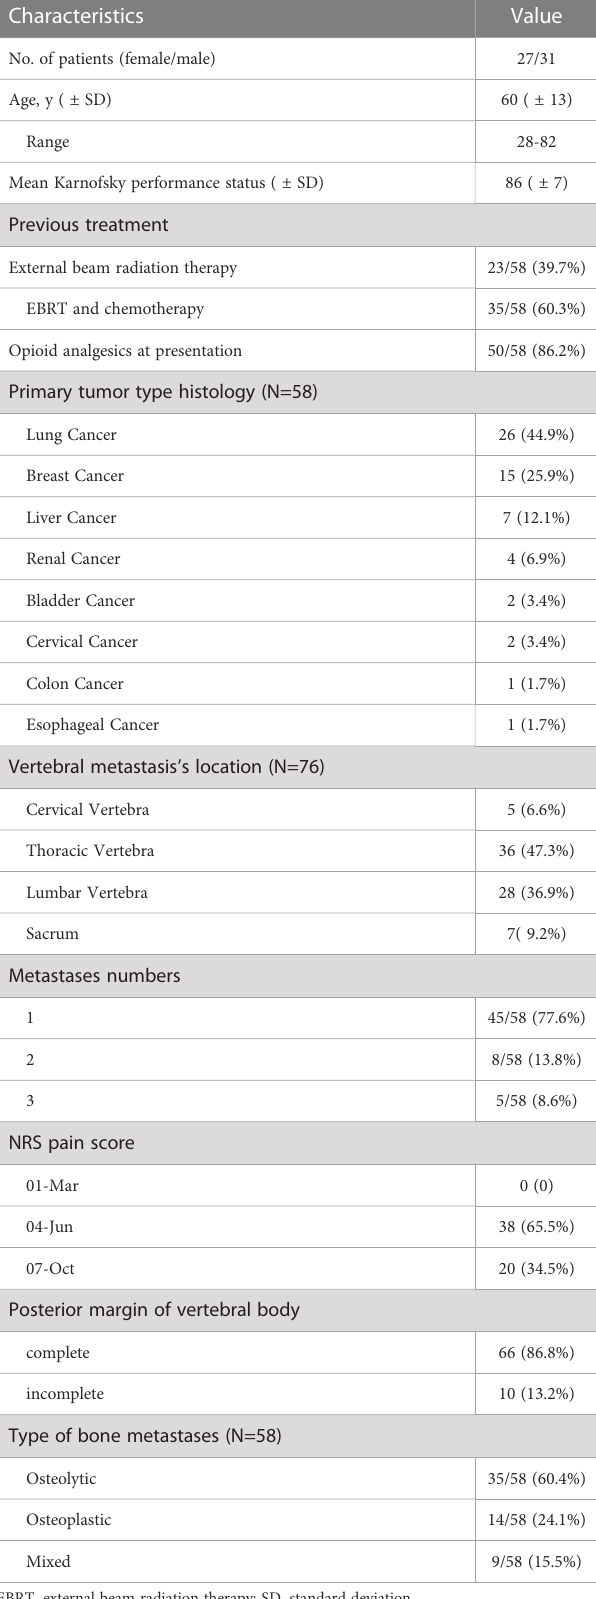
TABLE 1 Characteristics of patients before